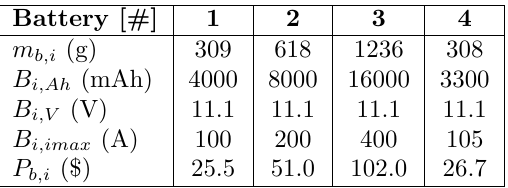
Table 5: Datasheets: Motors. m m,i is the motor weight, D m,i is the motor diameter, S l,i , S w,i are the shaft length and width, ρ m,i is the material density of the motor and P m,i is the motor price.